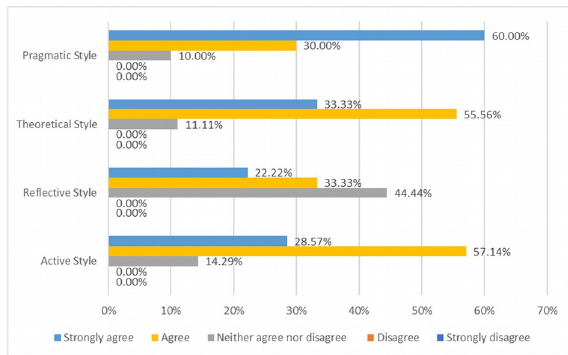
Figure 5. I have better access to learning materials and